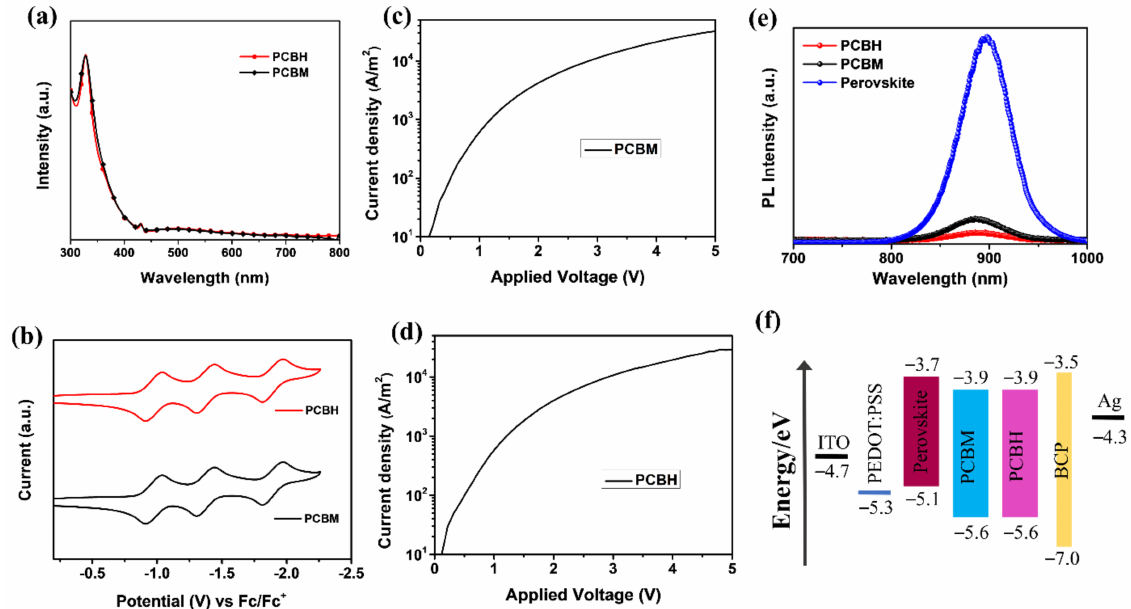
Figure 1. Electron density distributions determined by density functional theory (DFT) calcula- tion for PCBH and PCBM. ( a ) LUMO, ( b ) HOMO, ( c ) electrostatic potential (ESP) results, and ( d ) dipole moments.